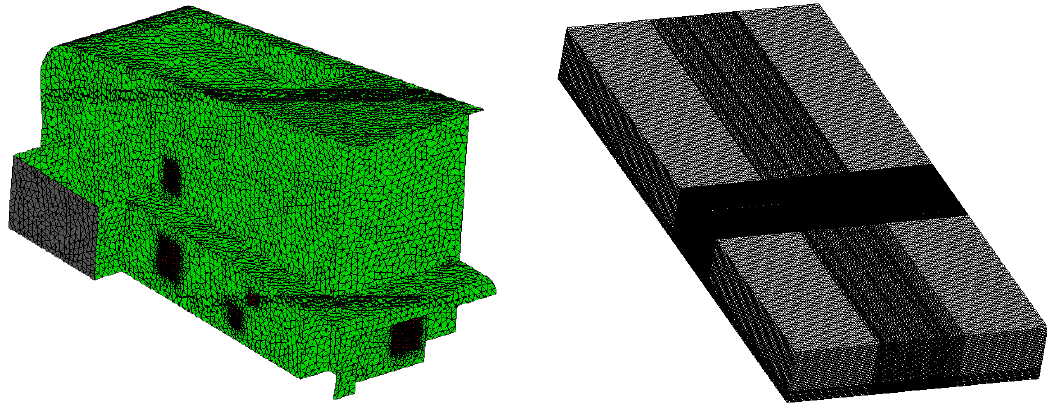
Figure 6. Grid analysis of local and overall areas of outdoor buildings.